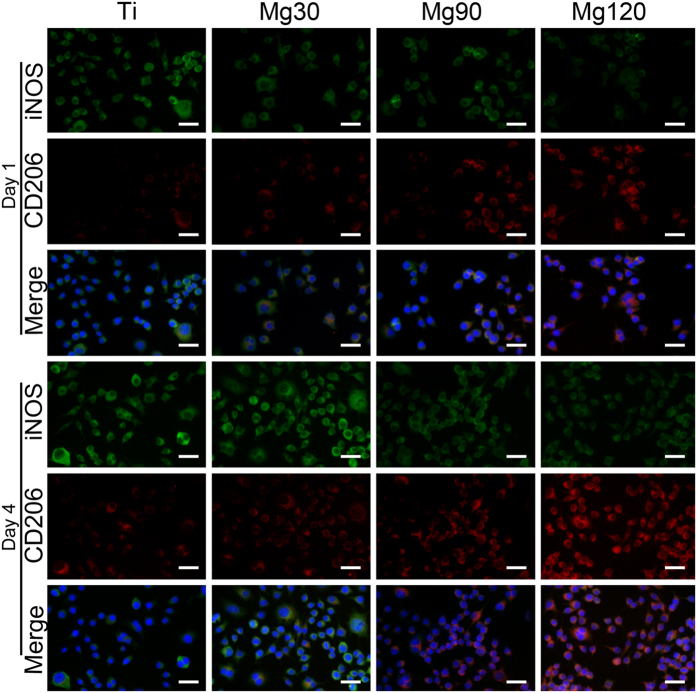
Images of immunofluorescent staining of the RAW cells adhered to various surfaces.iNOS (green fluorophore) indicates M1 macrophages; CD206 (red fluorophore) indicates M2 macrophages; nuclei are stained with DAPI (blue fluorophore); scale bar: 100 μm. (iNOS: inducible nitric oxide synthase; CD206: cluster of differentiation 206; DAPI: 4′,6-diamidino-2-phenylindole).